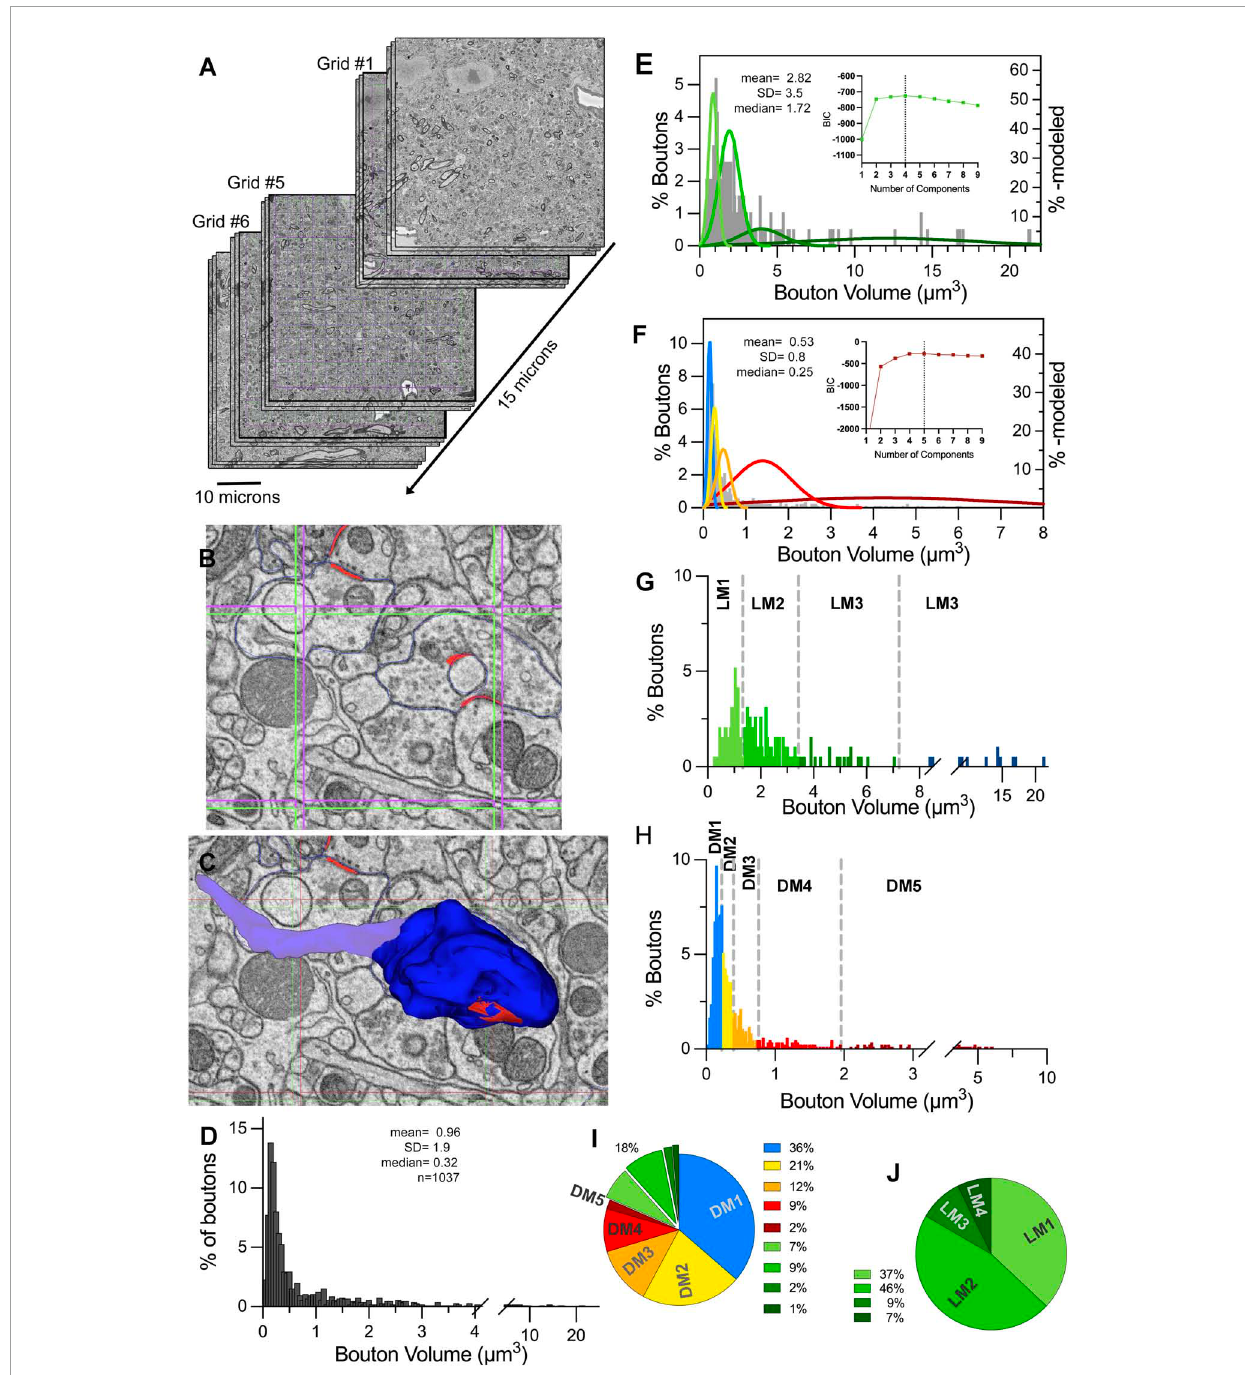
FIGURE1 Determining the cutoffs for volume-based terminal sorting using unbiased terminal sampling (UTS) methodology and statistical modeling. (A) The scheme of placing stereological grids on an SBEM stack, yielding 1,364 sampling locations within a 40 µ m × 40 µ m × 15 µ m tissue. For illustration purposes, only representative sections are depicted; and the Z-axis is expanded. (B) Within each stereological grid, synapses (outlined in red) are marked, including those touching the inclusion line (green lines) but excluding those touching the exclusion lines (purple lines). (C) The terminal boutons (e.g., dark blue) that form the “marked” synapses are reconstructed to reveal the 3D structure, and its volume is included in the UTS dataset. Care taken to not include the axon stalks or shafts (light blue) in the volume measurements. (D) The volume frequency histogram of all terminals collected with UTS, displaying a wide and irregular distribution. (E) The volume frequency distribution of boutons with light mitochondria (LM) terminals (gray bars) with overlaid normal distributions of four subpopulations modeled via BIC (four shades of green bell curves). Inset shows the BIC for models with different numbers of components. The vertical line marks the model with the highest BIC number. (F) Volume frequency distribution of boutons with dark or no mitochondria (DNM) terminals (gray bars) with overlaid normal distributions of five subpopulations modeled via BIC (blue, yellow, orange red, and burgundy bell curves). Inset shows the BIC for models with different numbers of components. The vertical line marks the model with the highest BIC number. (G,H) The cutoff values (vertical dashed lines) that are estimated via Monte Carlo simulations are applied to LM (G) and DNM (H) populations that are sampled via UTS. LM1, LM2, L3, and LM4 subpopulations in panel (G) , and DM1, DM2, DM3, DM4, and DM5 subpopulations in panel (H) are further color-coded. (I,J) The percent contributions of each subpopulation within the overall dataset (I) and within the LM population only (J) . Subpopulation color-coding for LM1-4 and DM1-5 correspond to those in panels (G,H)